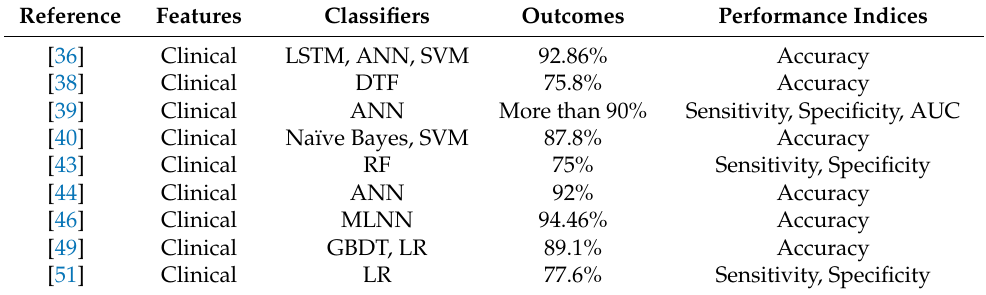
Table 1. Related